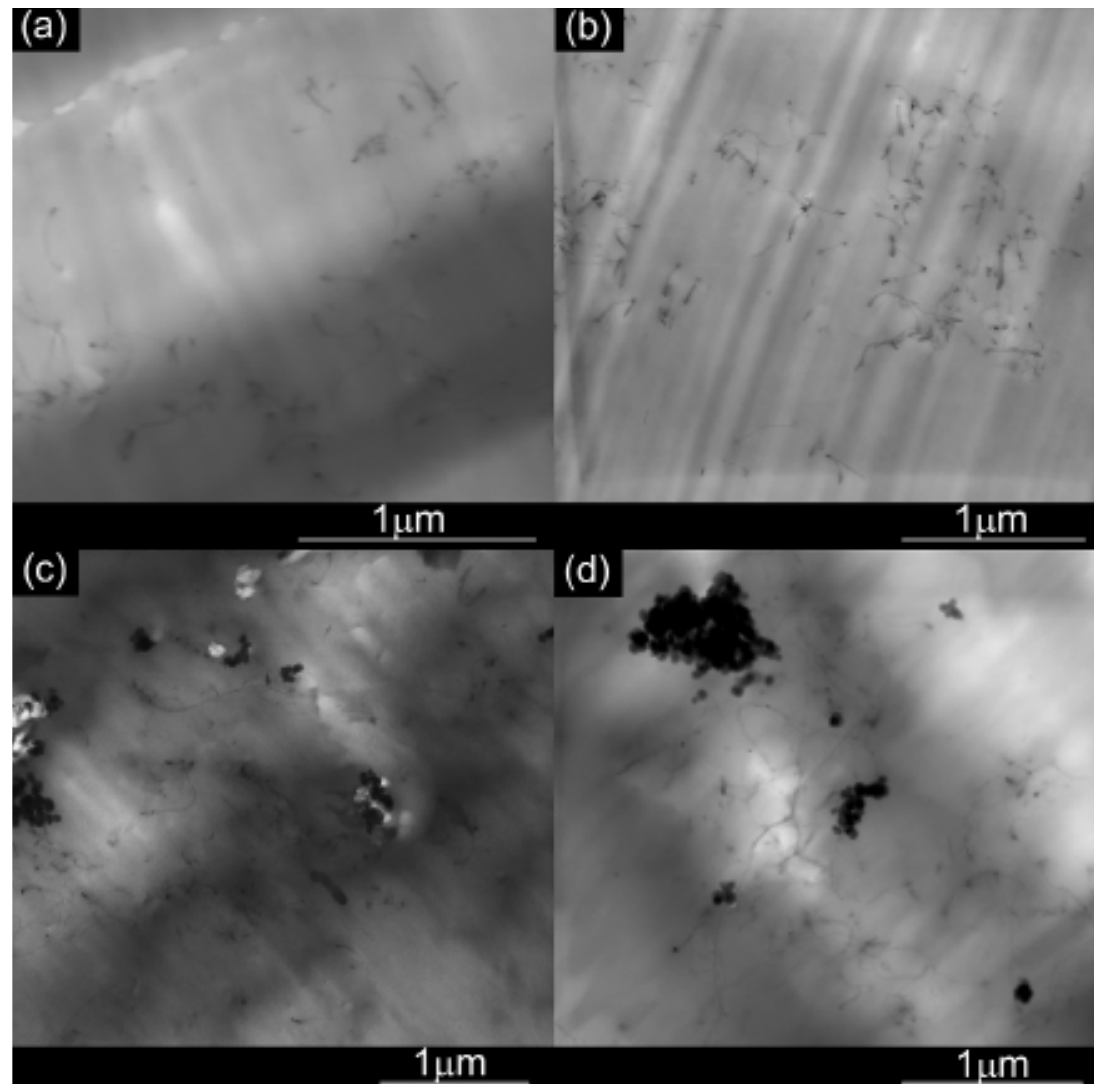
Figure 1. TEM micrographs C1 and C2: (a) C1 130.000x, (b) C2 100.000x, (c) C1C 80.500x, (d) C2C